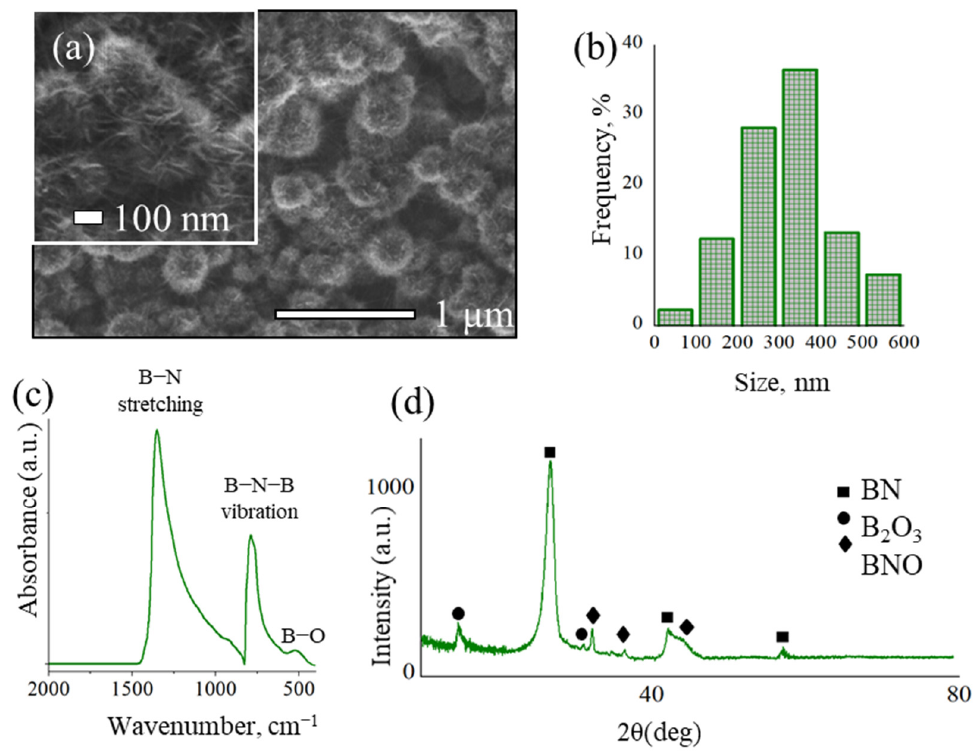
Figure 1. SEM micrographs at low and high (inset) magnifications ( a ), size distribution of BNNPs ( b ), FTIR spectrum ( c ) and XRD pattern ( d ) of BN coating.